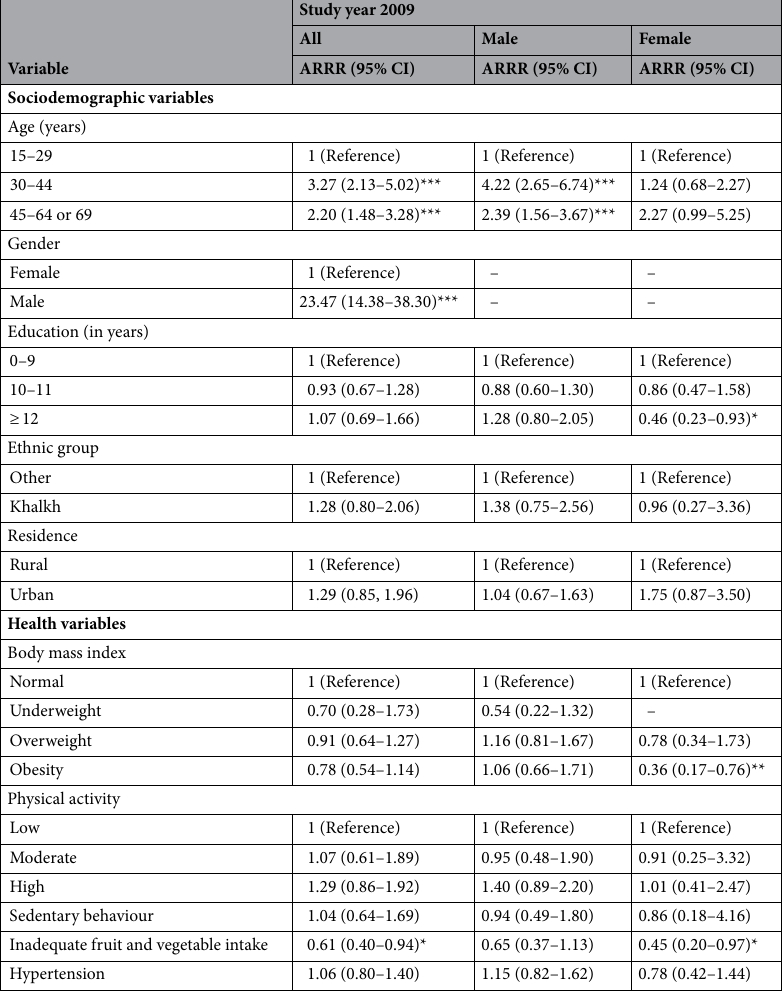
Table 16. Associations with current tobacco use and current heavy drinking (with non-current tobacco and non-current heavy drinking as reference category) among 15 years and older individuals in Mongolia,